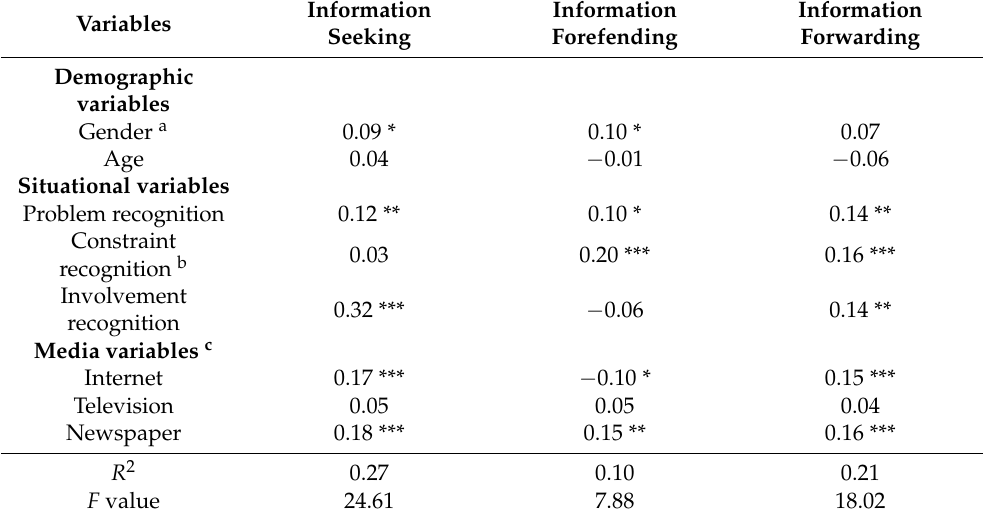
Table 7. Using active publics about the issue of GM foods, multiple regression analysis predicting information seeking, information forefending, and information forwarding in China (N =